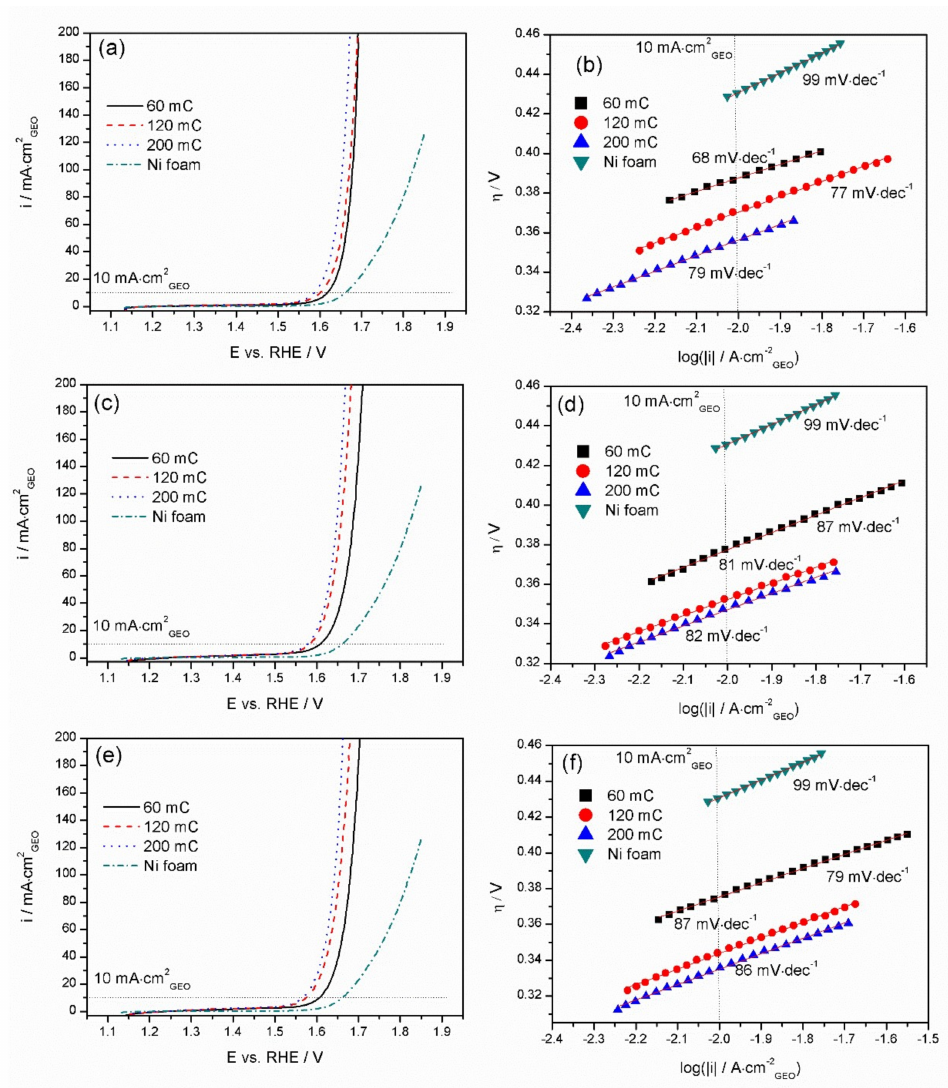
Figure 5. Linear sweep voltammetry profiles and corresponding Tafel plots for Mn-Co film synthesised in the presence of ( a , b ) Mn / Co 2 mM / 4 mM, ( c , d ) 2 mM / 6 mM, and ( e , f ) 2 mM / 8 mM on nickel foam measured in Ar-purged 1 M